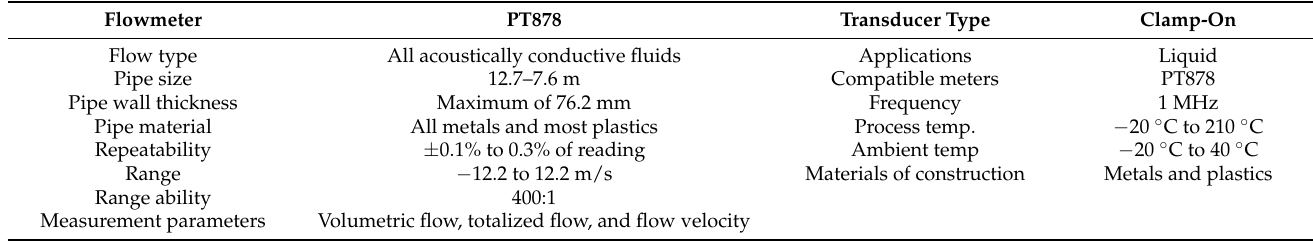
Table 2. Ultrasonic flowmeter and transducer